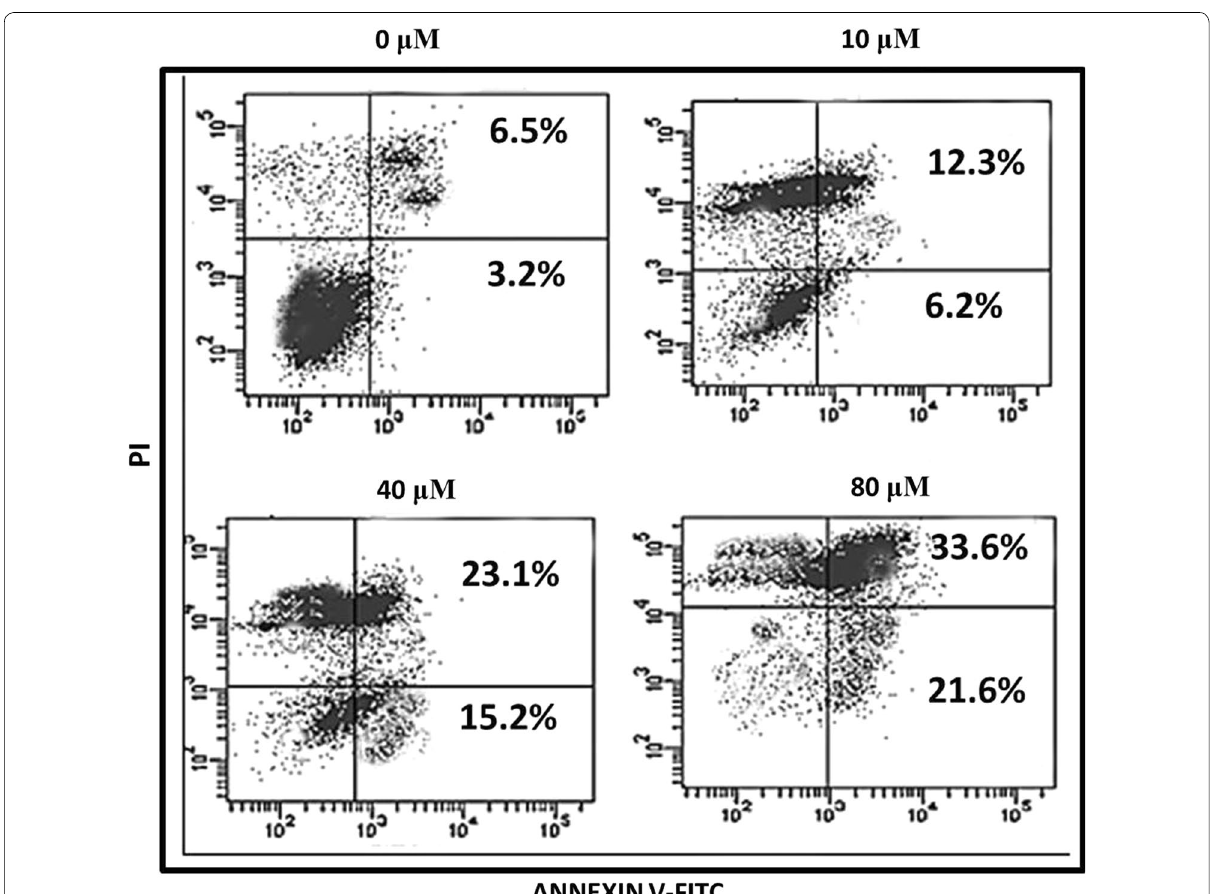
Fig. 5 Flow cytometric quantification of rate of apoptosis after treatment with maslinic acid against neuroblastoma cells at indicated doses. Results indicated that percentage apoptosis increased potentially on increasing the maslinic acid concentrations as indicated. All the data indicated in this figure are represented as mean SD and p < 0.05 was considered as statistically ±